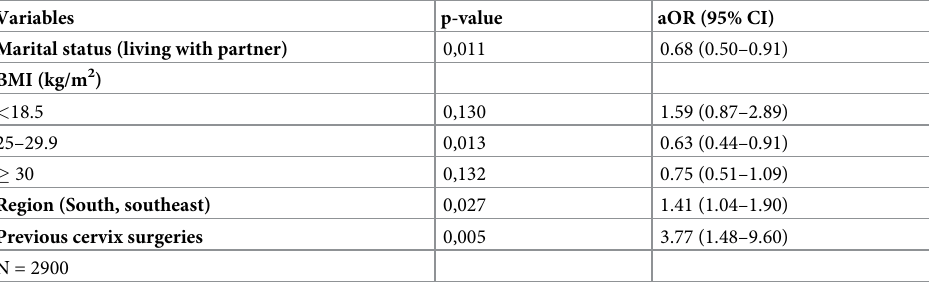
Table 5. Multiple analysis for cervical length � 25 mm in women without previous